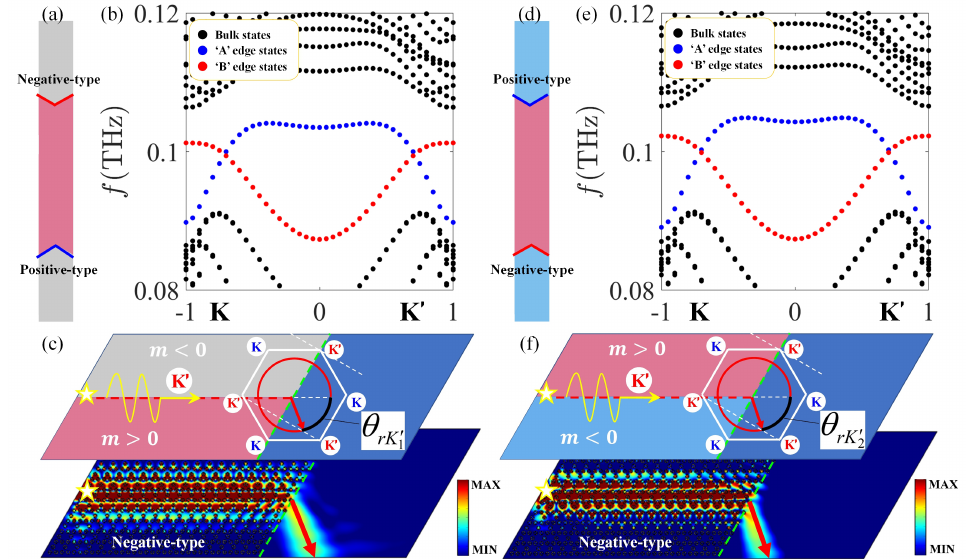
Figure A2. ( a ) Supercell and ( b ) bands of topological insulator with α = 30 ◦ , θ = − 180 ◦ (gray) and α = 30 ◦ , θ = − 110 ◦ (light red). ( c ) The k -space analysis on the out-coupling of K (cid:48) valley and projected edge states along negative-type (Zigzag) interface. ( d ) Supercell and ( e ) bands of topological insulator with α = 30 ◦ , θ = − 70 ◦ (light red) and α = 30 ◦ , θ = 0 ◦ (light blue). ( f ) The k -space analysis on the out-coupling of K (cid:48) valley and projected edge states along negative-type (Zigzag) interface. In ( b , e ), dashed black curves represent the bulk modes. The dashed red/blue curves represent the negative-type/positive-type interfaces edge states. In ( c , f ), the white solid hexagon represents the first Brillouin zone. The red solid circle shows the dispersion in background material Si. Simulated distribution of fields at frequency f = 0.1 THz and f = 0.101 THz are separately illustrated in the bottom panels.